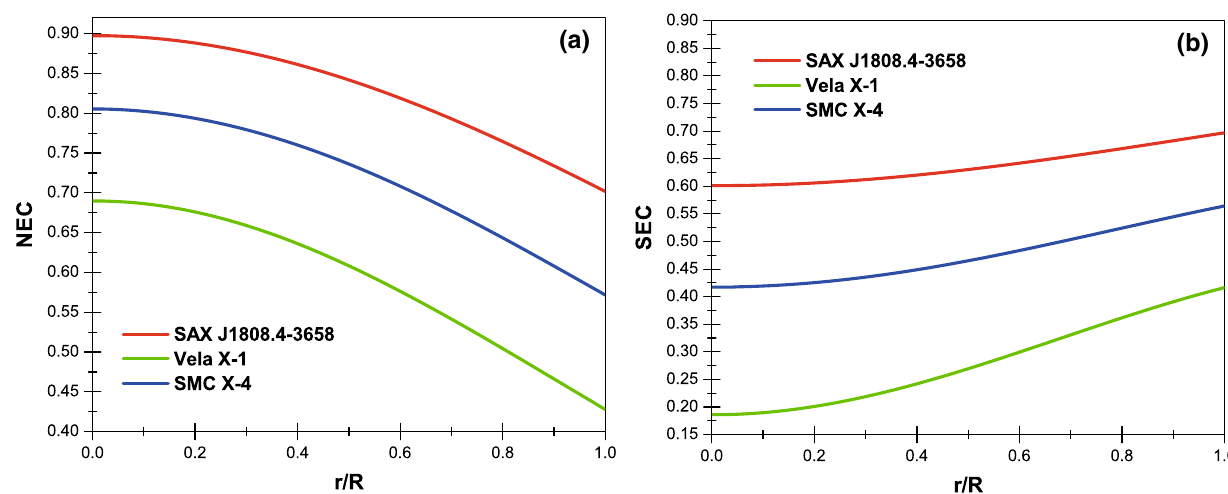
Fig. 12 Null energy condition panel a and Strong energy condition panel